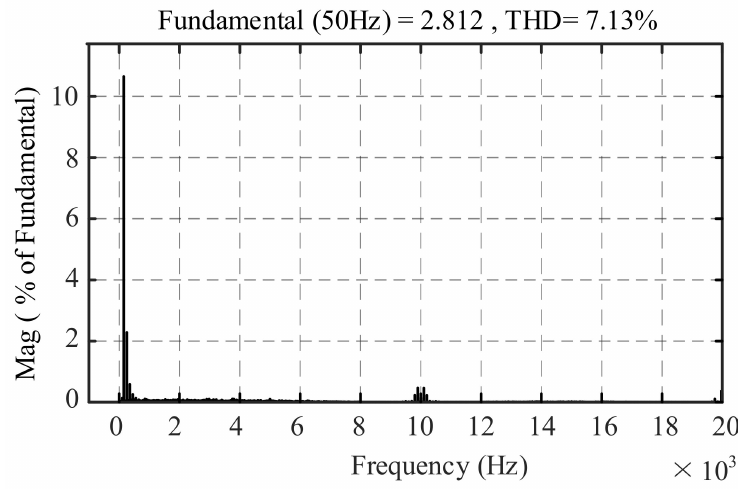
Figure 6. Spectrum analysis of A-phase current of conventional FCS-MPDPC.